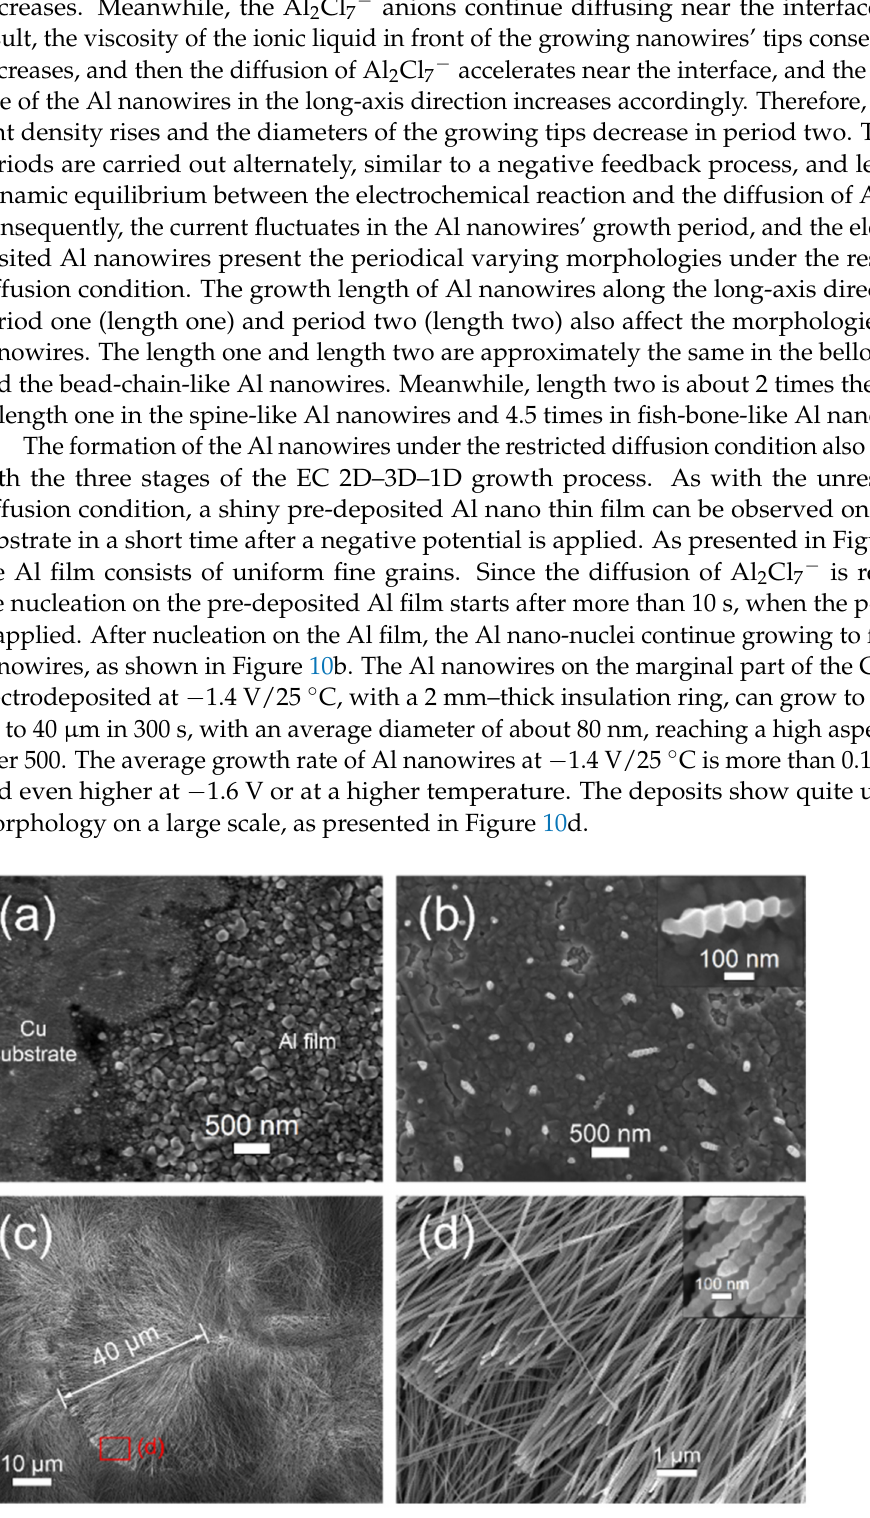
Figure 10. SEM images of the deposits obtained in potentiostatic electrodeposition at − 1.4 V/25 ◦ C ( c , d ) under the diffusion restricted condition with a 2 mm–thick insulation ring (inner diameter was 6 mm): ( a ) Al nano thin film on the Cu substrate after electrodeposition of 15 s, ( b ) Al nano-nuclei and short Al nanowires after electrodeposition of 25 s and ( c , d ) Al nanowires after electrodeposition of 300